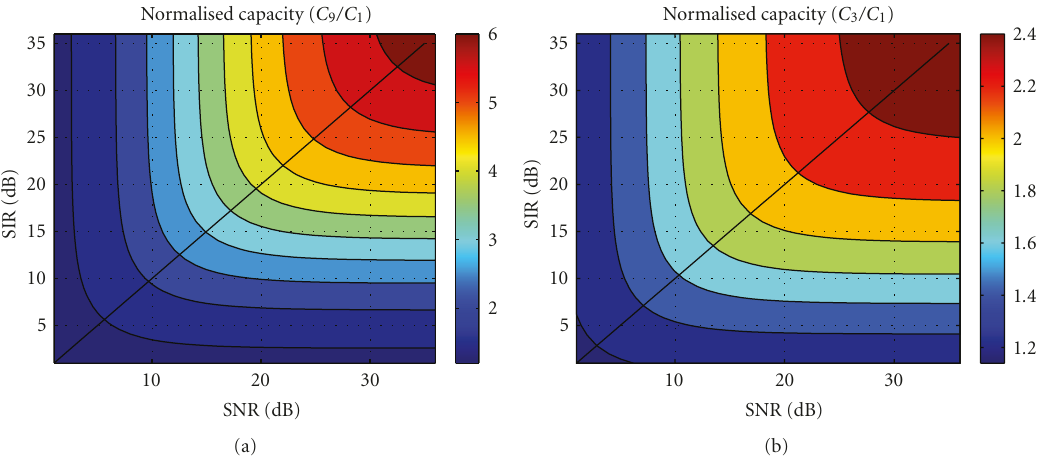
Figure 7: Data rate of the proposed modulation scheme against both SNR and SIR normalized to the data rate of m = 1 for (a) m = 9 (b) m = 3.